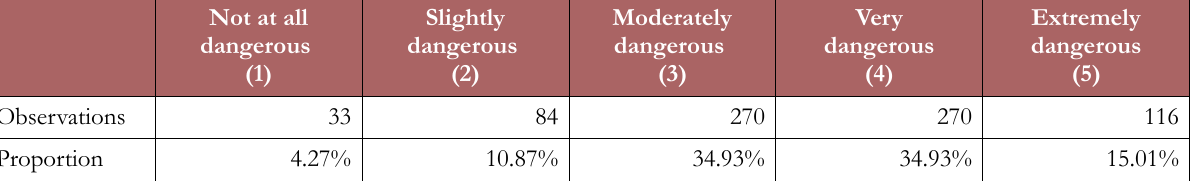
Table 1. Frequency table of perceived safety at